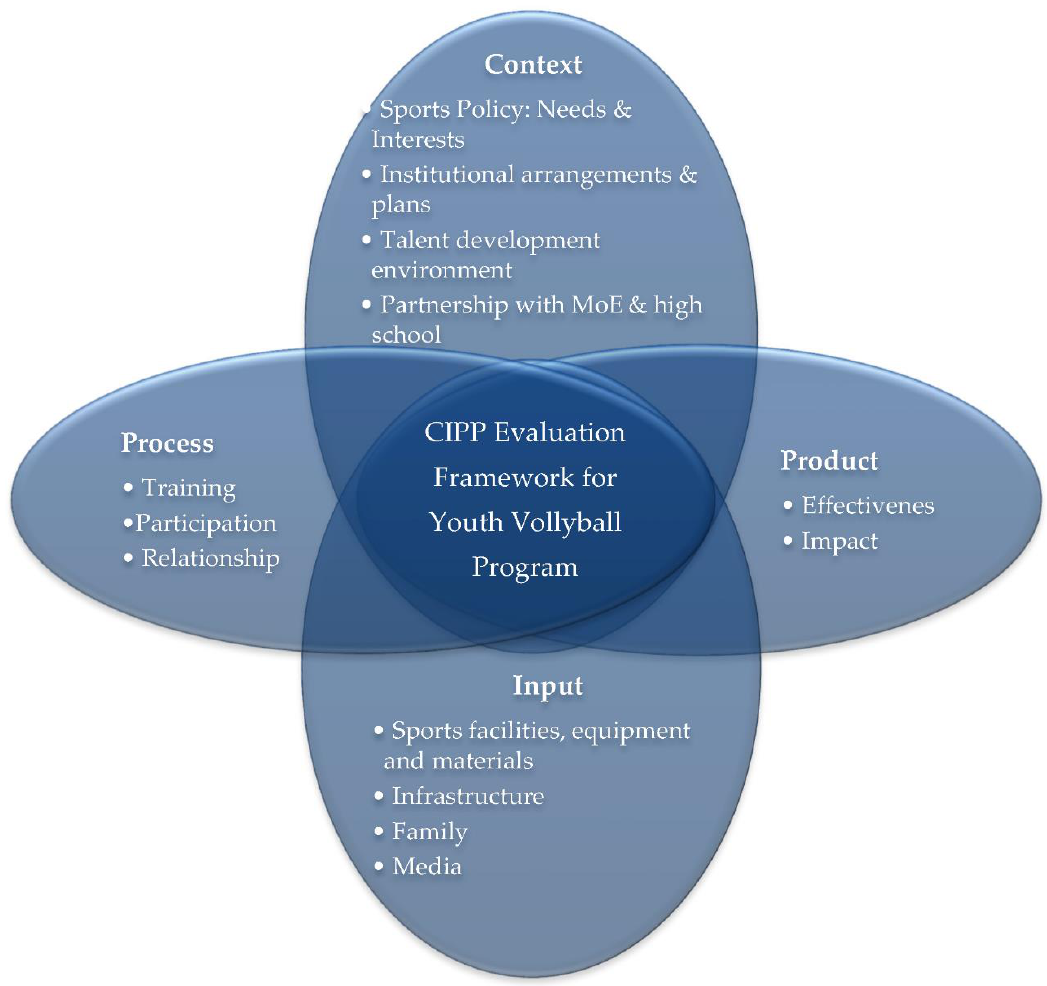
Figure 2. Hierarchical themes organizing framework.